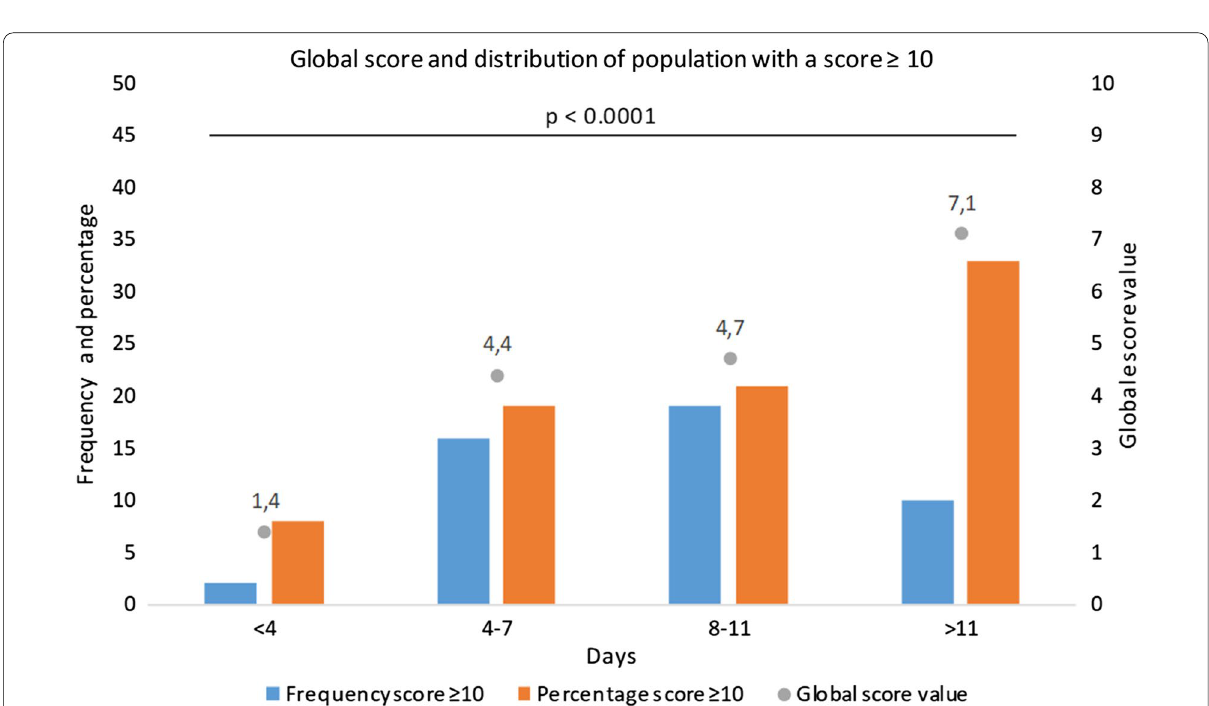
Fig. 4 Distribution of the population with a score 10 and mean score according to delay between symptom appraisal and chest CT. Note: We can ≥ see that the global score is higher and the proportion of score 10 is also higher according to the delay between the first symptom occurring and ≥ the chest CT. There was a significant difference between all